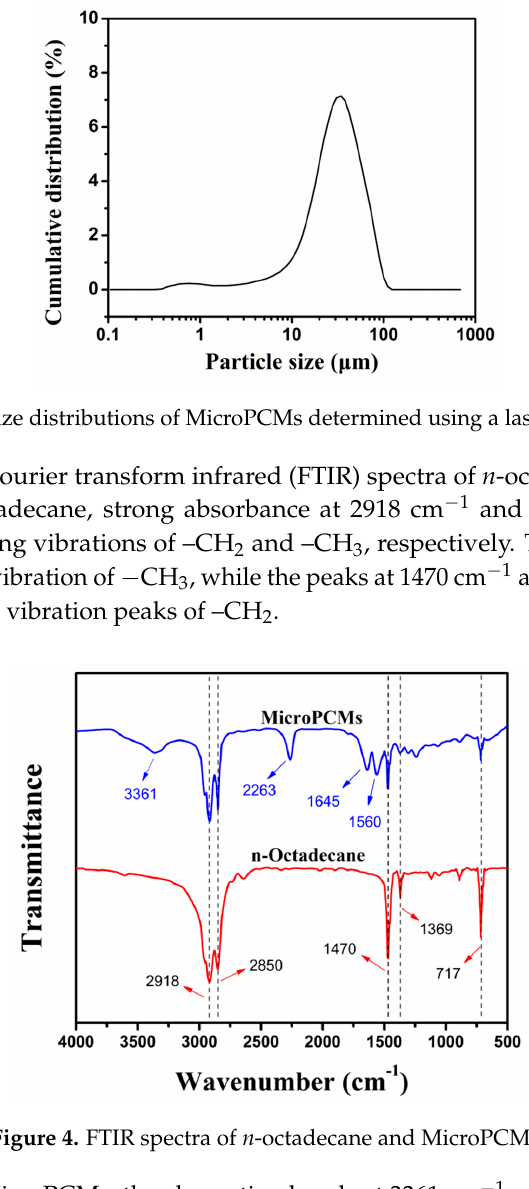
Figure 4. FTIR spectra of n ‐ octadecane and MicroPCMs.